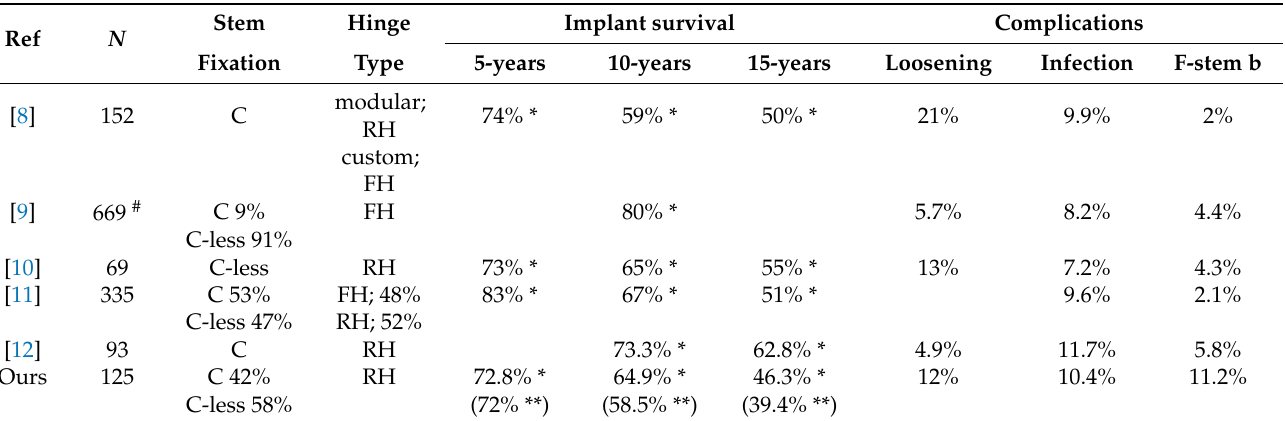
Table 4. The long-term (Mean follow-up duration > 10 years) clinical outcome in patients with prosthetic replacement at distal part of the